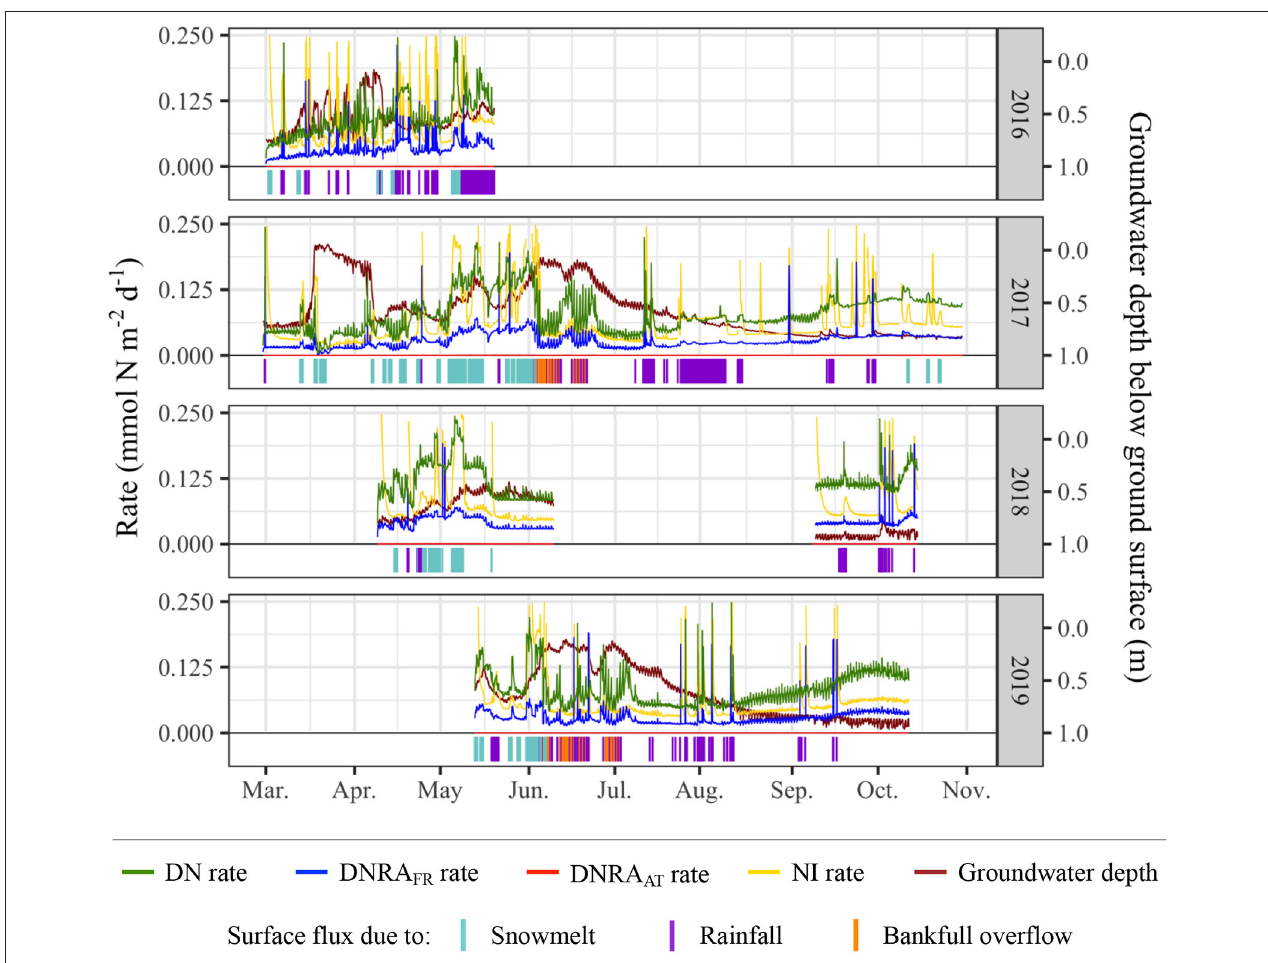
FIGURE 9 | N-transformation rates, groundwater depth, and surface flux periods/sources. In the bottom portion of each plot, the presence of a vertical line indicates surface flux occurring at that time, and the color of the vertical line represents the source of the surface flux. Simulations were only run for periods when sufficient data were